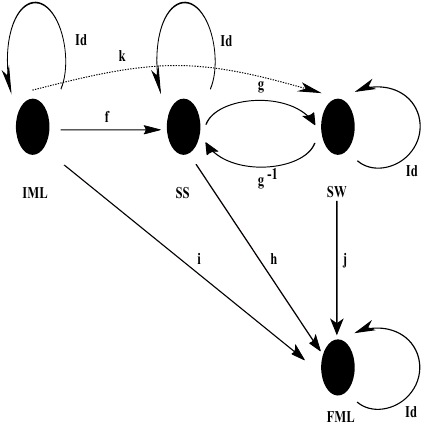
Figure 5. Tensional coherence